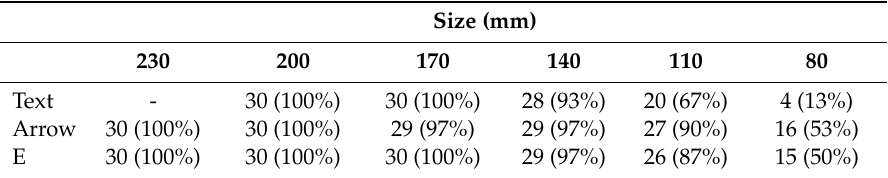
Table 3. Correct identification in absolute and relative terms ( n = 30).